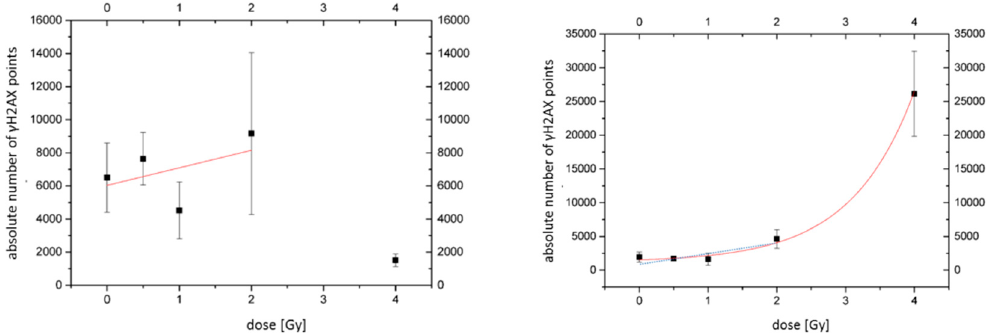
Figure 10. Dose–efficiency curves (number of γ H2AX labelling tags vs. dose counted by SMLM). For the irradiated SkBr3 cell nuclei without Au-NP incorporation (left graph, a linear increase (red fit curve) can be observed at doses between 0 and 2 Gy. This was compatible to the blue linear fitting curve for irradiated SkBr3 cell nuclei with Au-NP incorporation (right graph. For the higher dose values, an exponential growth (red fit curve) or quadratic increase could be fitted to the values. (black square: mean value; error bar: standard deviation)